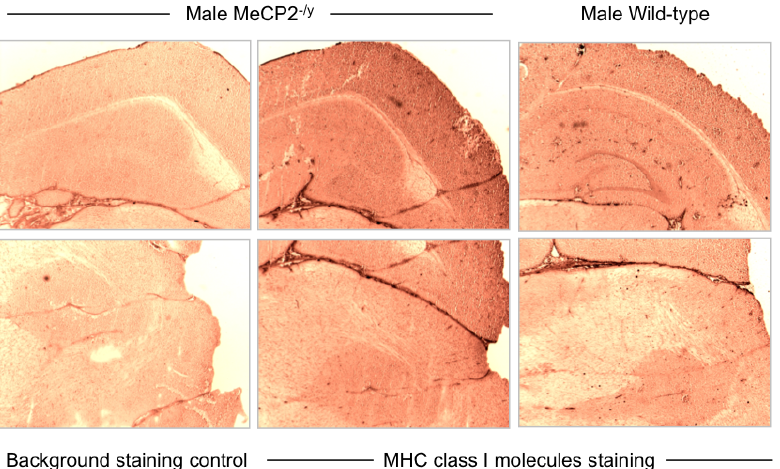
Figure 4. Evaluation of MHC class I expression in adult mouse brain slices. Serial frozen sections of adult male wild-type and MeCP2 2 /y littermates were analysed for expression of MHC class I by immunohistochemistry using the rat R1-21.2 monoclonal antibody and EnVision detection technology (Dako). For the negative control, the same staining process was used omitting the primary antibody. Similar results were obtained with the M1/42 monoclonal antibody. Similar results were obtained in independent experiments on brains from three different pairs of mice.